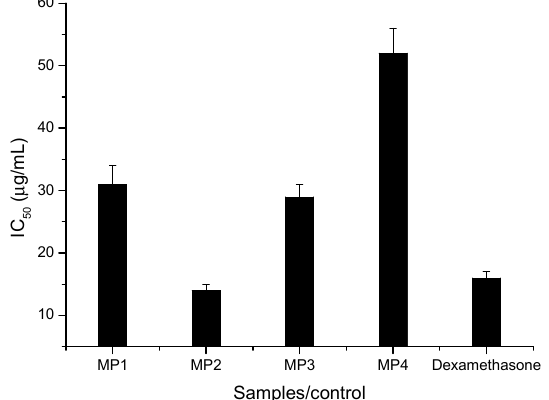
Figure 3. Anti-inflammatory activity of propolis samples expressed in IC 50 values (µg/mL) of NO production inhibition (mean ± SD, n = 2). IC 50 values correspond to the extract concentration achieving 50% of the inhibition of the NO production.